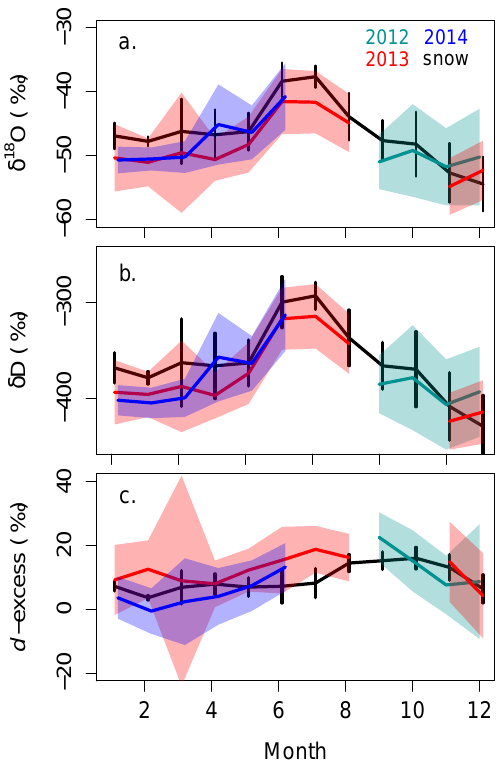
Figure 10. Contributions to measurement uncertainty at Summit include prediction errors from correcting the concentration depen- dence with a locally weighted polynomial regression (black), mea- surement repeatability errors (gray), which are estimated from the root mean square error associated with fitting a linear regression to the concentration-corrected calibration data, and instrument preci- sion (blue), estimated from the standard deviations of the 1-minute calibration measurements made at volume mixing ratios match- ing the mean q for each month. These uncertainties are shown for (a) δ 18 O, (b) δ D, and (c) deuterium excess for the Gulper analyzer. with a ∼ 1 ◦ C change in air temperature – assuming tempo- ral δ 18 O–temperature relationships in Greenland water vapor are approximately 0.8 ‰ ◦ C − 1 (Steen-Larsen et al., 2014a) – increasing the instrumental precision at low q and correct- ing changes in measurement repeatability on daily-to-weekly time scales would both be desirable. Better